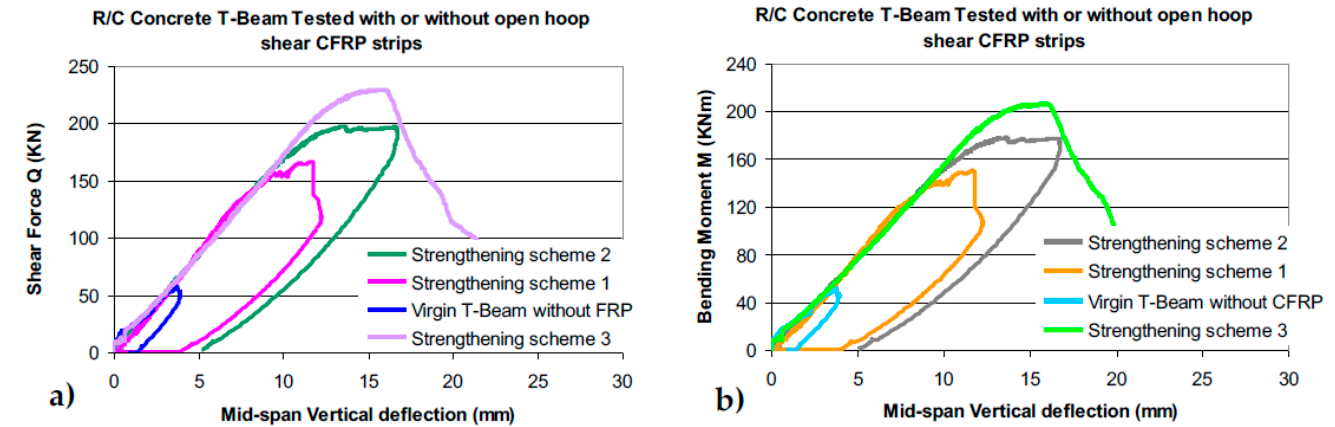
Figure 21. The 3 rd st rengthening scheme . Open hoop CFRP strips with mechanical anchors at the West part and closed hoop anchor ropes at the East part (The same as in S t rengthening scheme 2 ). The flexural upgrade of the 3rd strengthening scheme consisted of five (5) CFRP layers (each 0.131 mm thick and 120 mm wide) attached at the bottom side of the T-beam specimen.